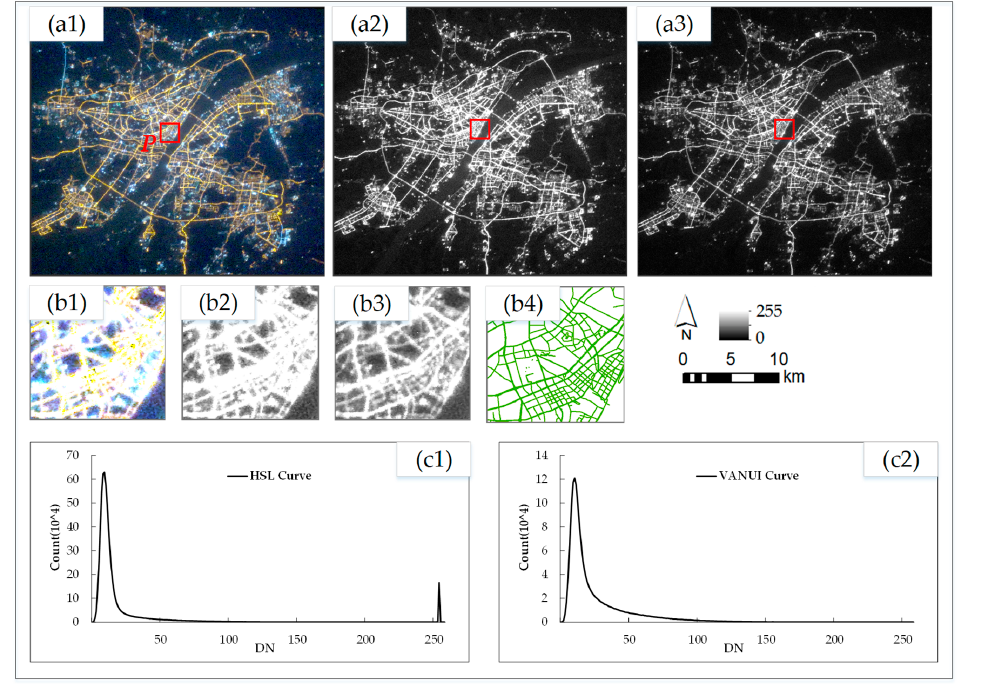
Figure 4. ( a1 – a3 ) Comparison of original International Space Station (ISS), hue saturation lightness (HSL), and Vegetation Adjusted NTL Urban Index (VANUI) images. ( b1 – b4 ) Sample region showing the comparison of original ISS, HSL, VANUI images and actual road networks. ( c1 , c2 ) Comparison of DN curve between HSL and VANUI images.